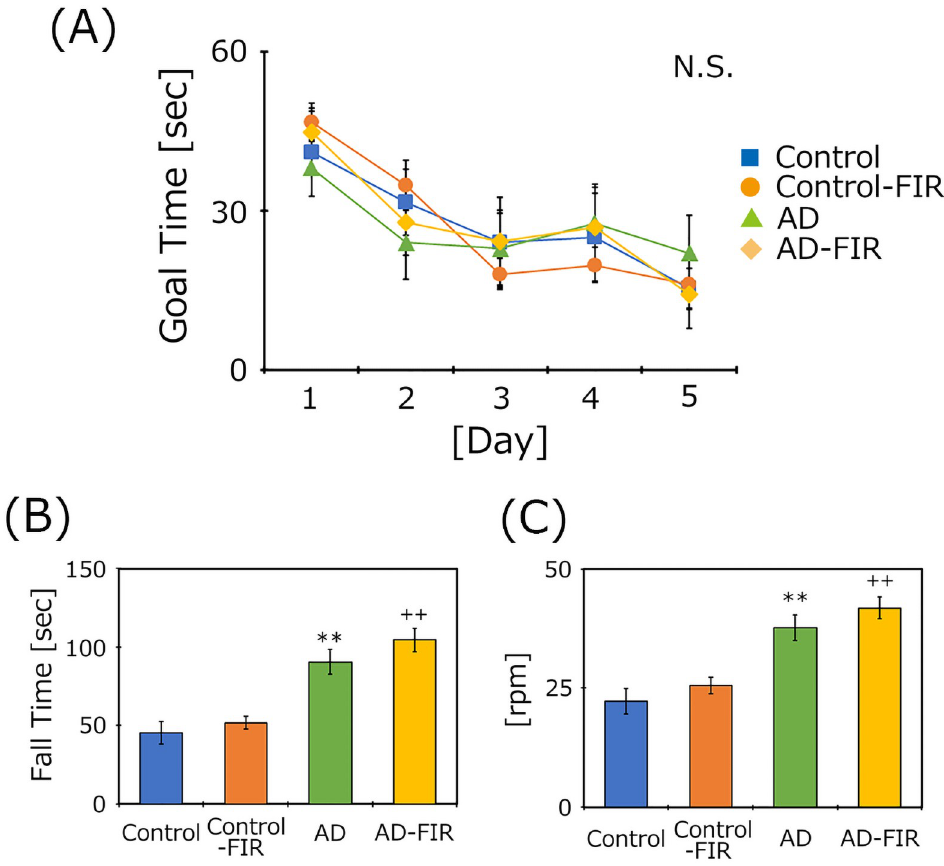
Fig 4. Assessment of cognitive and motor functions in the presence or absence of FIR light of the two mouse groups using (respectively) the Morris water maze test (A) and the Rota Rod test (B)(C). Data are expressed as means + SE (Control, n = 5; Control-FIR, n = 5; AD, n = 6; AD-FIR, n = 6). Data in Fig 4A were analyzed using two- way ANOVA; data in Fig 4B and 4C were analyzed using Tukey-Kramer’s tests. N.S., not significant ( p � 0.05). �� p < 0.01 vs. Control, ++ p < 0.01 vs.